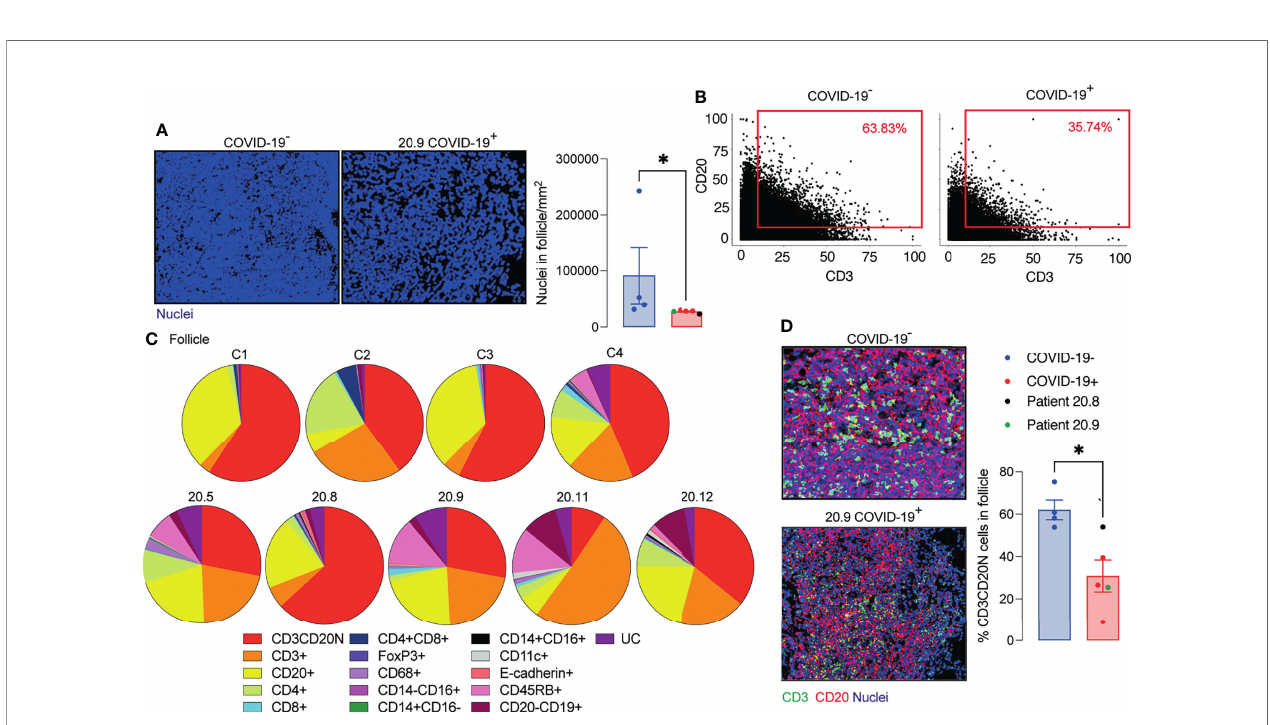
FIGURE 4 | Decreased T and B cell interaction in ileal follicles in Peyer ’ s patches (PP) of COVID-19 patients. (A) Representative images from histoCAT showing nuclear density in ileal follicles in Peyer ’ s Patch (PP) from COVID-19 - and COVID-19 + patients on the left; and mean data on the right. (B) Dot-plots showing the interaction between T and B cells in ileal follicles. (C) Percentages of different cellular types in follicles from each control and COVID-19 + patient. CD3CD20N: T and B cell neighbours. UC, unclassi fi ed cells. (D) Representative images from histoCAT showing CD3 (green) and CD20 (red) merged signals (yellow) on the left the mean of proportions of CD3CD20 neighbours (CD3CD20N) on the right. Data is shown as mean ± SEM. (n = 4 controls and 5 patients). Mann-Whitney t test in (A, D) *P <